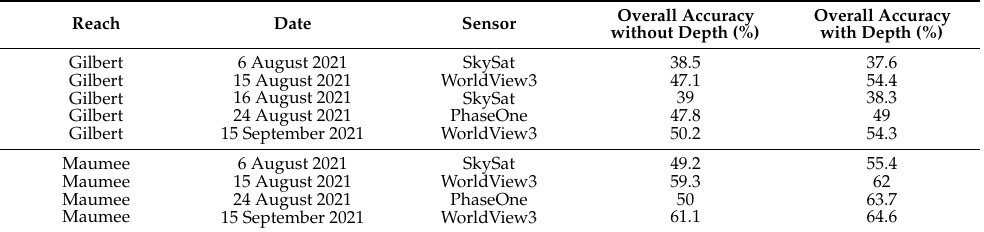
Table 4. Accuracy assessment of Buffalo River algal classifications based on five-fold cross-validation. Reach Date Sensor Overall Accuracy without Depth (%) Overall Accuracy with Depth